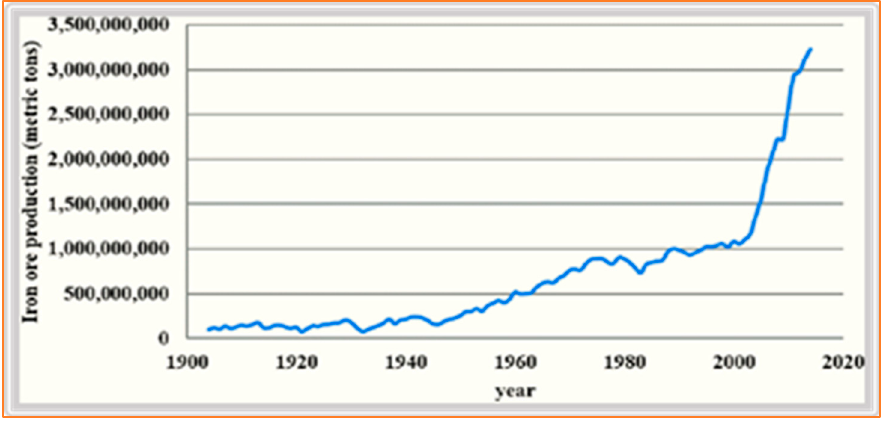
Figure 3. World iron ore production from 1904 to 2014 (USGS 2015).